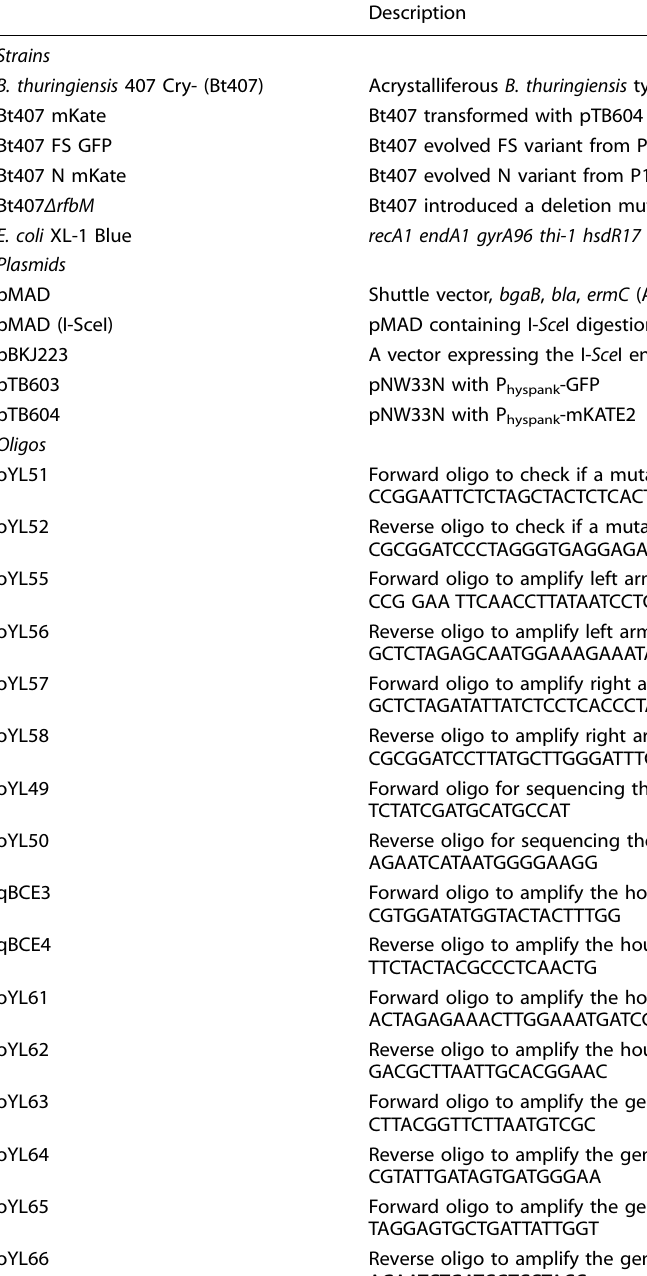
Table 1. Information of strains, plasmids, and oligos used in this study.